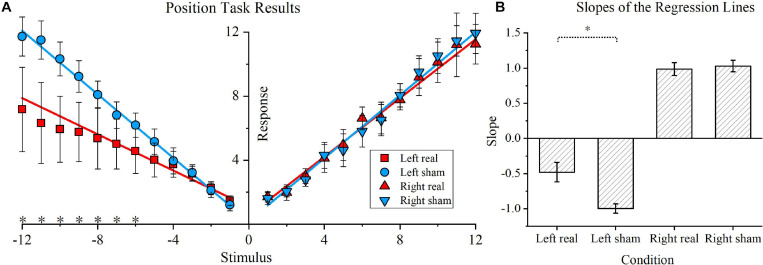
Position task and position bias results. (A) Position task results. The blue circle and inverted blue triangle represent the sham transcranial direct current stimulation (tDCS) condition for the leftward and rightward rotations, respectively. Correspondingly, for the real tDCS condition, a red square and red triangle represent the responses of the two stimulus directions. The linear regression lines for the real and sham tDCS condition are also denoted by blue and red lines, respectively. Asterisks are used to indicate significant differences between the real and sham tDCS conditions in the specific stimulus position. (B) Slopes of the regression lines for the four conditions. The slopes of the regression lines for the left real, left sham, right real, and right sham condition were calculated for each participant. The mean values and standard deviations of the four slopes are shown, and the vertical lines represent standard errors of the mean.